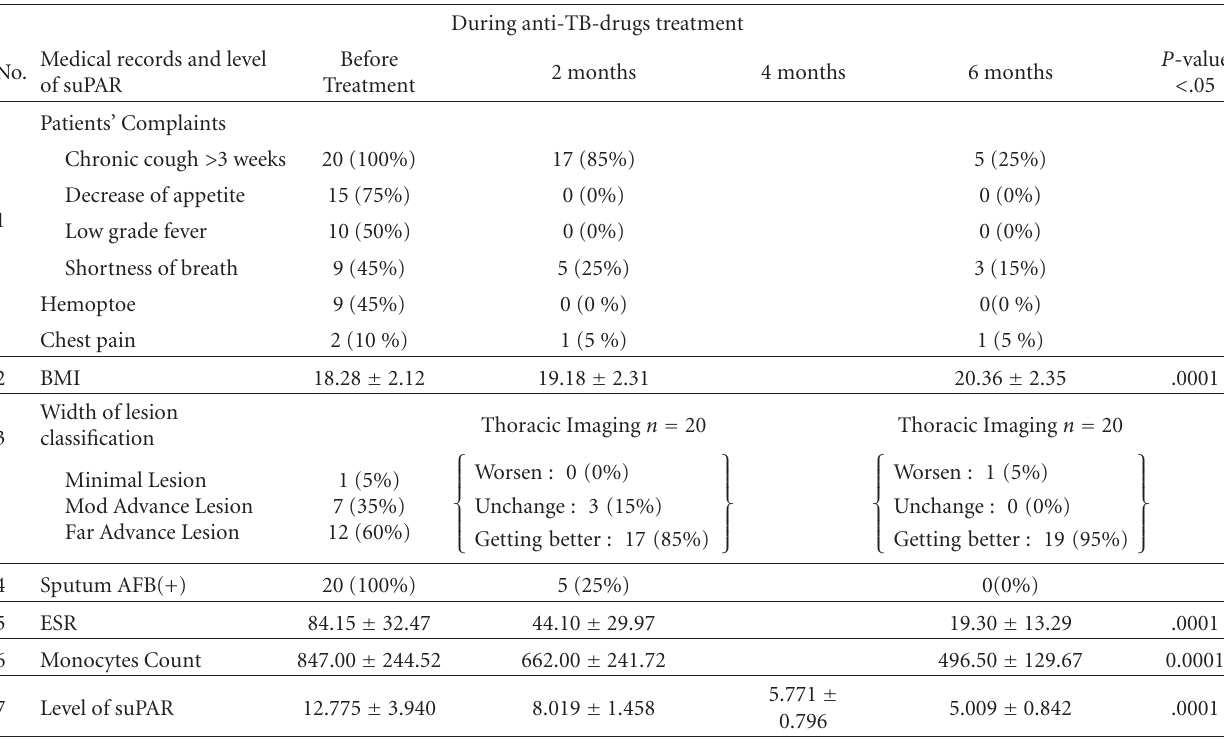
Table 2: Comparison between medical records used to monitor TB theraphy progress in Indonesia, that is, patients complaints, BMI (kg/m 2 ), width of lesion, sputum AFB, erythrocyte sedimentation rate (mm/hour), monocyte count (cell/mm 2 ), and soluble urokinase plasminogen activator receptor during the 6-month